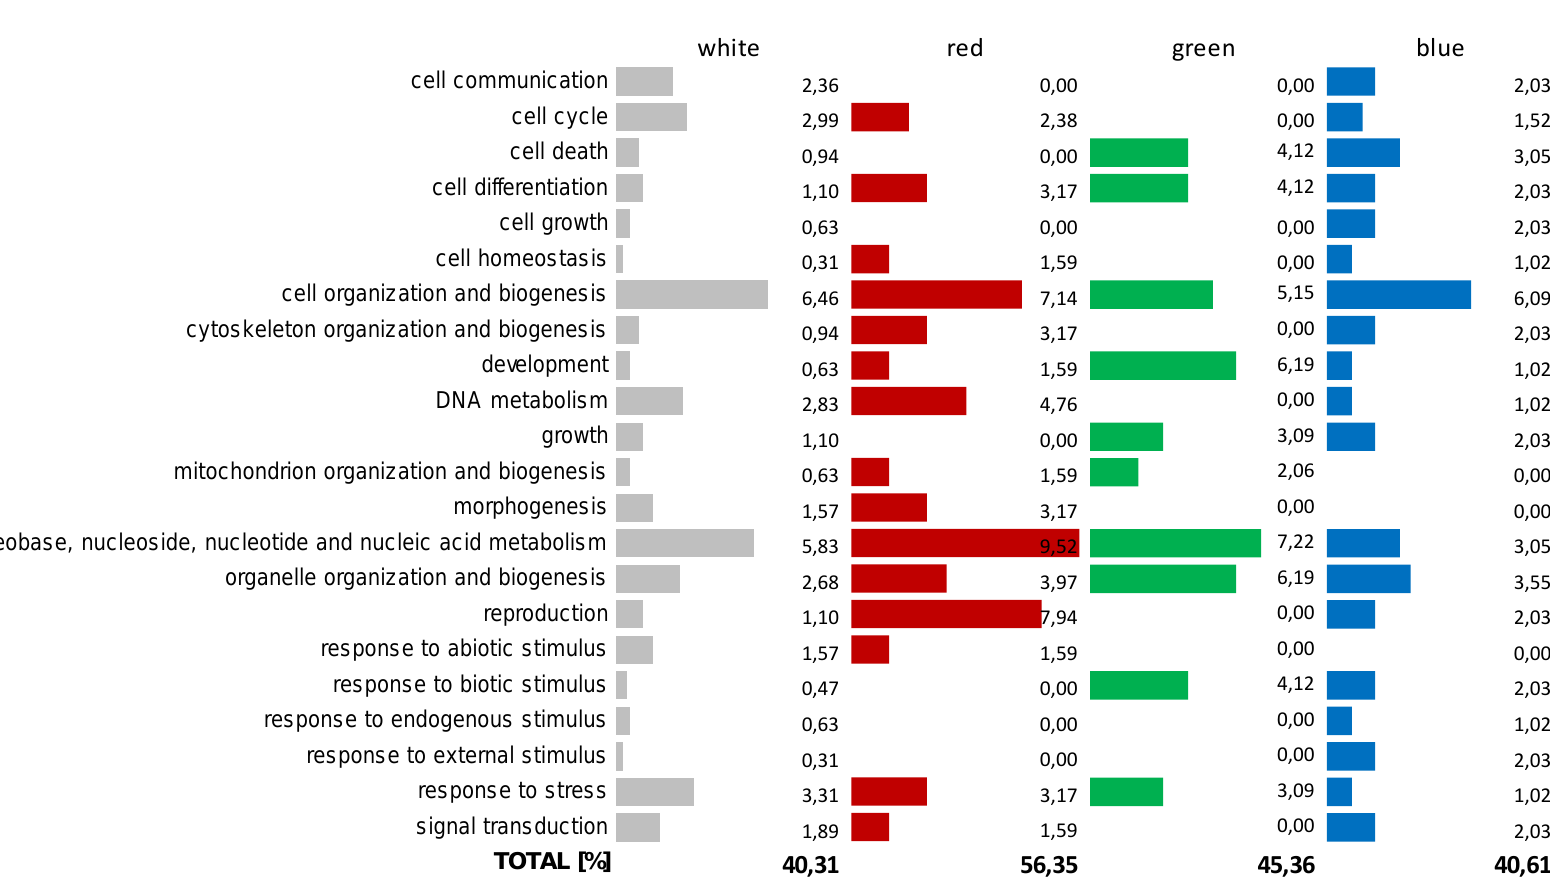
Figure 4. GO annotation of Cerrena unicolor 451 DEGs putatively engaged in fungal growth, development, and morphology. Color bars represent % of DEGs specific for fungus cultivation in different lighting conditions, which received GO annotations referring to biological processes related with C. unicolor growth and morphology. DEGs were grouped into nine functional categories: cellular process, developmental process, growth, homeostatic process, cellular component organization and biogenesis, primary metabolic process, metabolic process, reproduction, and response to stimulus (numerous DEGs were classified into more than one GO category). Only DEGs whose abundance among GO terms exceeded 1% for at least one lighting variant were presented.